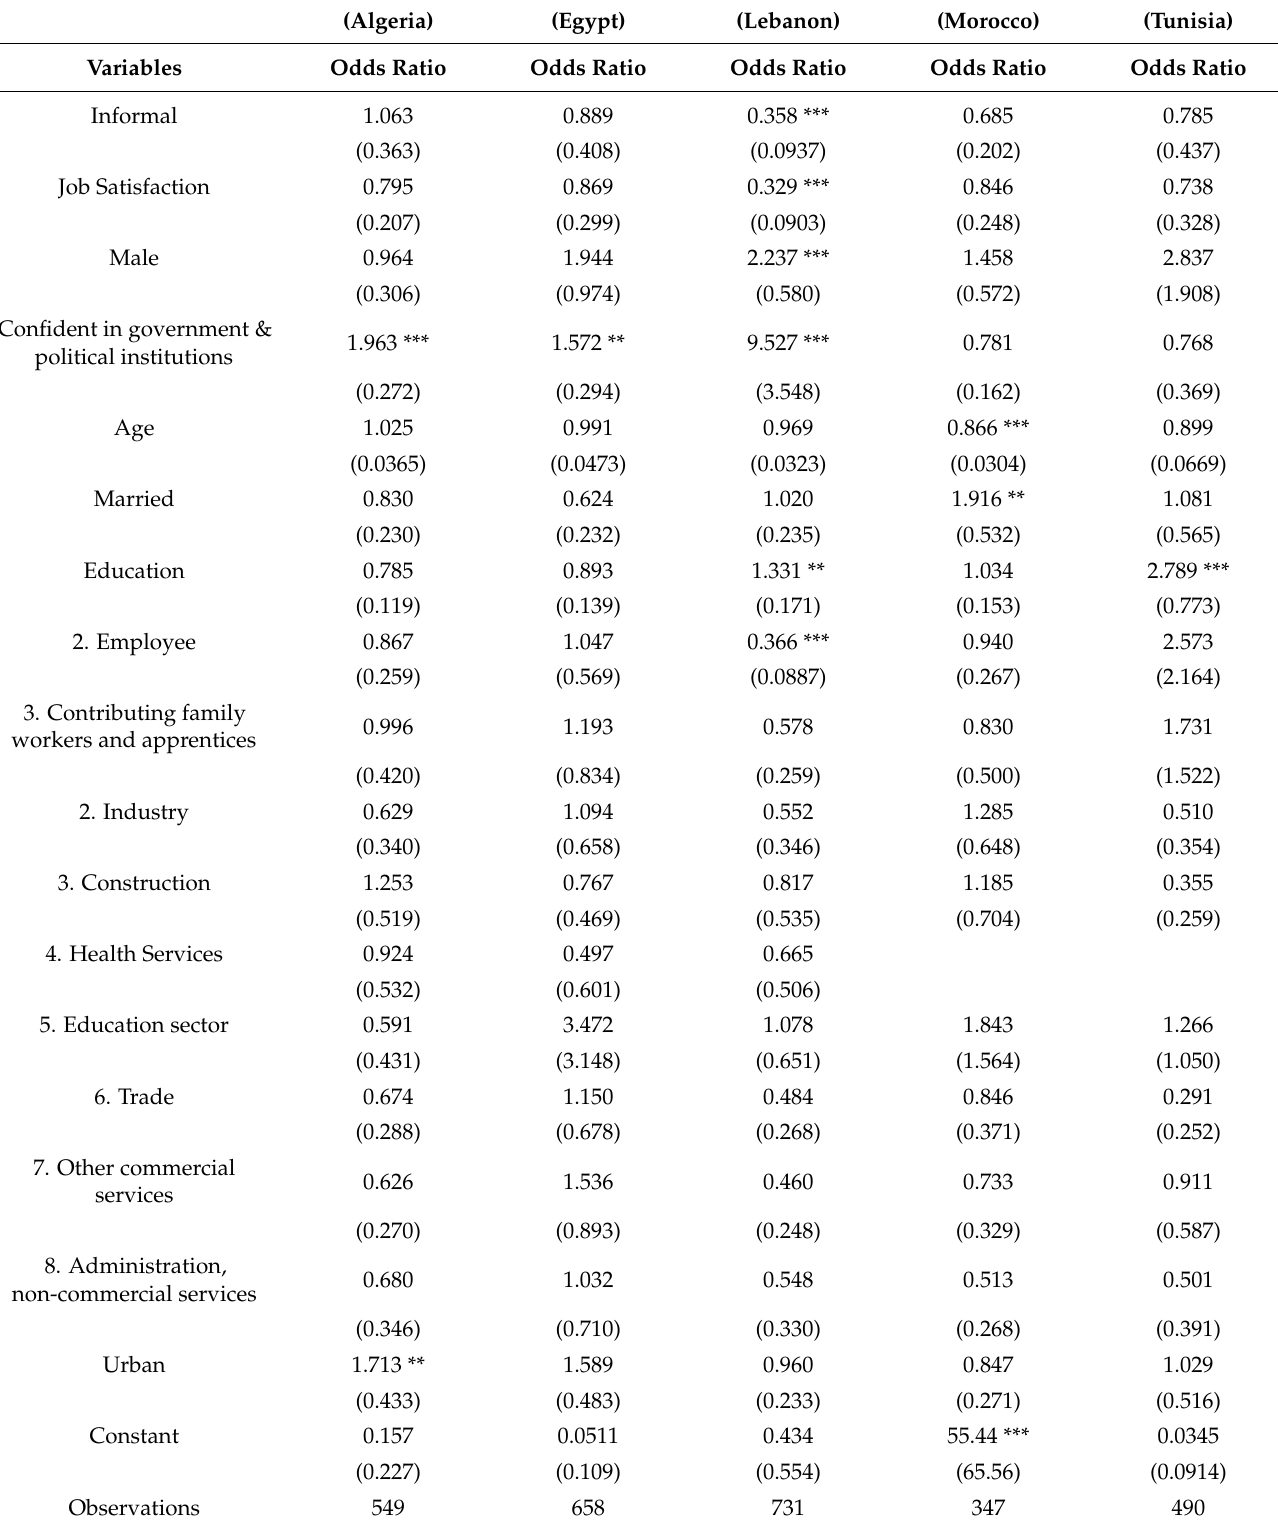
Table A4. Logistic regression on the participation index by